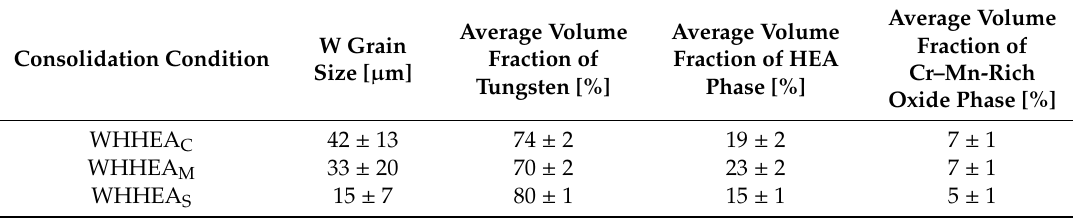
Table 4. Table showing the average W grain size and the volume fraction of the observed three di ff erent phases (W, HEA and Cr–Mn-rich oxide